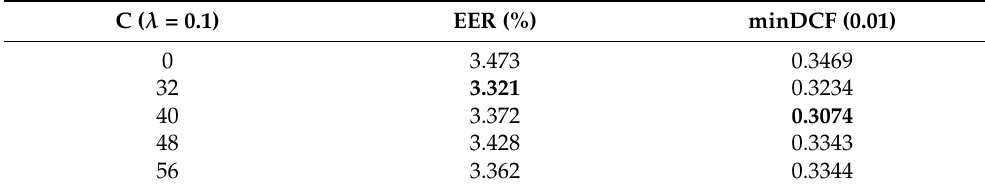
Table 6. Exploration of the effect of different C on VoxCeleb. (AM-Softmax + λ PPL). C ( λ = 0.1)